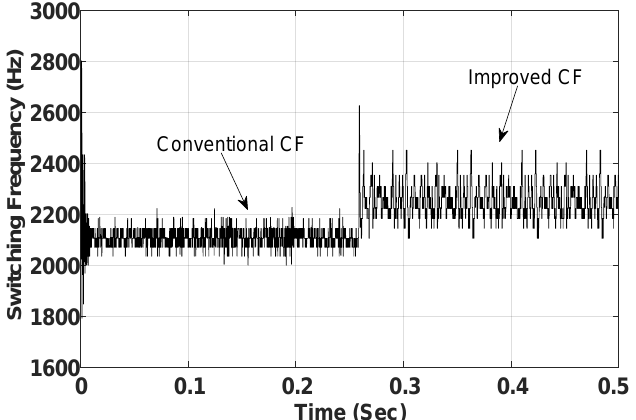
Figure 15. The measured switching frequency for the conventional and improved CFs using a periodic control strategy.